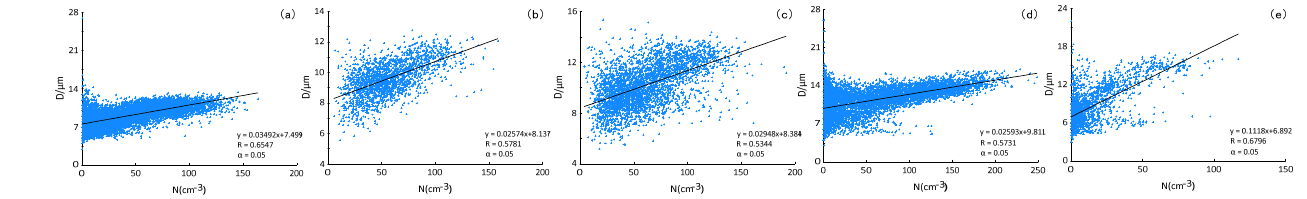
Figure 12. Correlation analysis between D ( µ m) and N C (cm − 3 ) in the case1 process, gestation stage, and intermittent stage. ( a ) Gestation stage, ( b ) formation stage, ( c ) development stage, ( d ) maturation and dissipation stage, ( e ) intermittent stage.